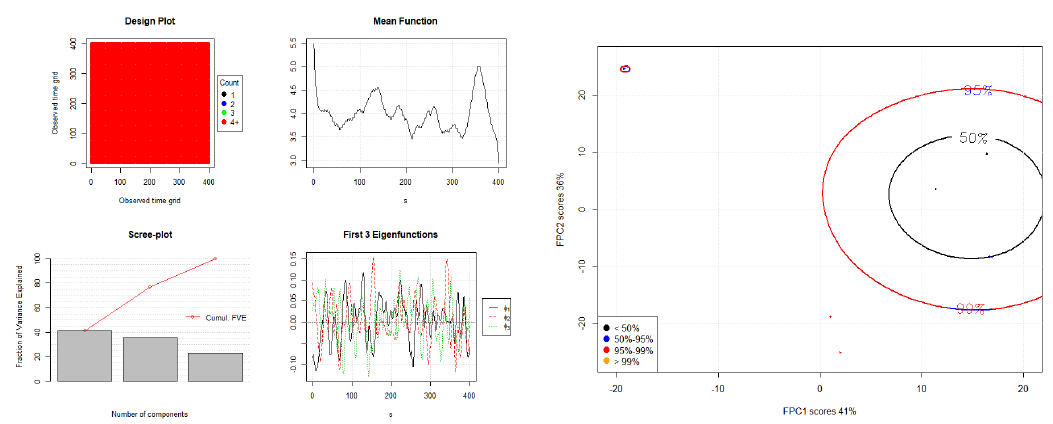
Figure 4. FPCA plots of X 3